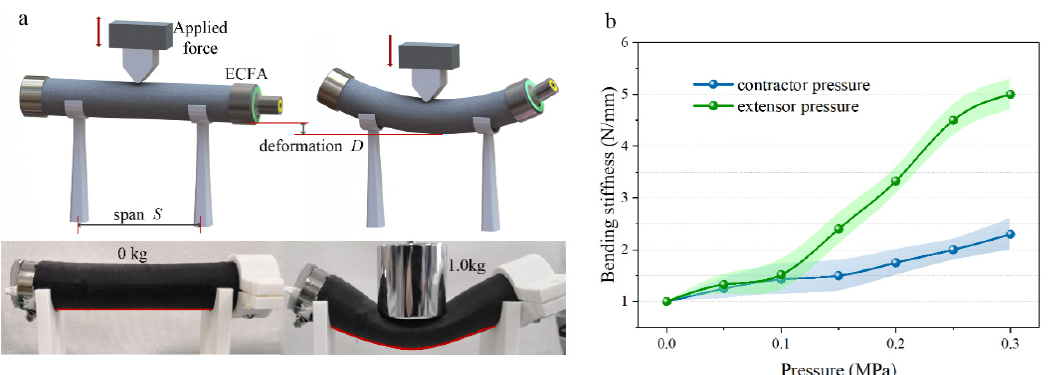
Figure 11. Bending stiffness of the actuator. ( a ) Stiffness estimation under flexural loading of the actuator. ( b ) The pressure-stiffness experiment result of independently pressurizing the extensor or contractor muscles of the actuator separately.